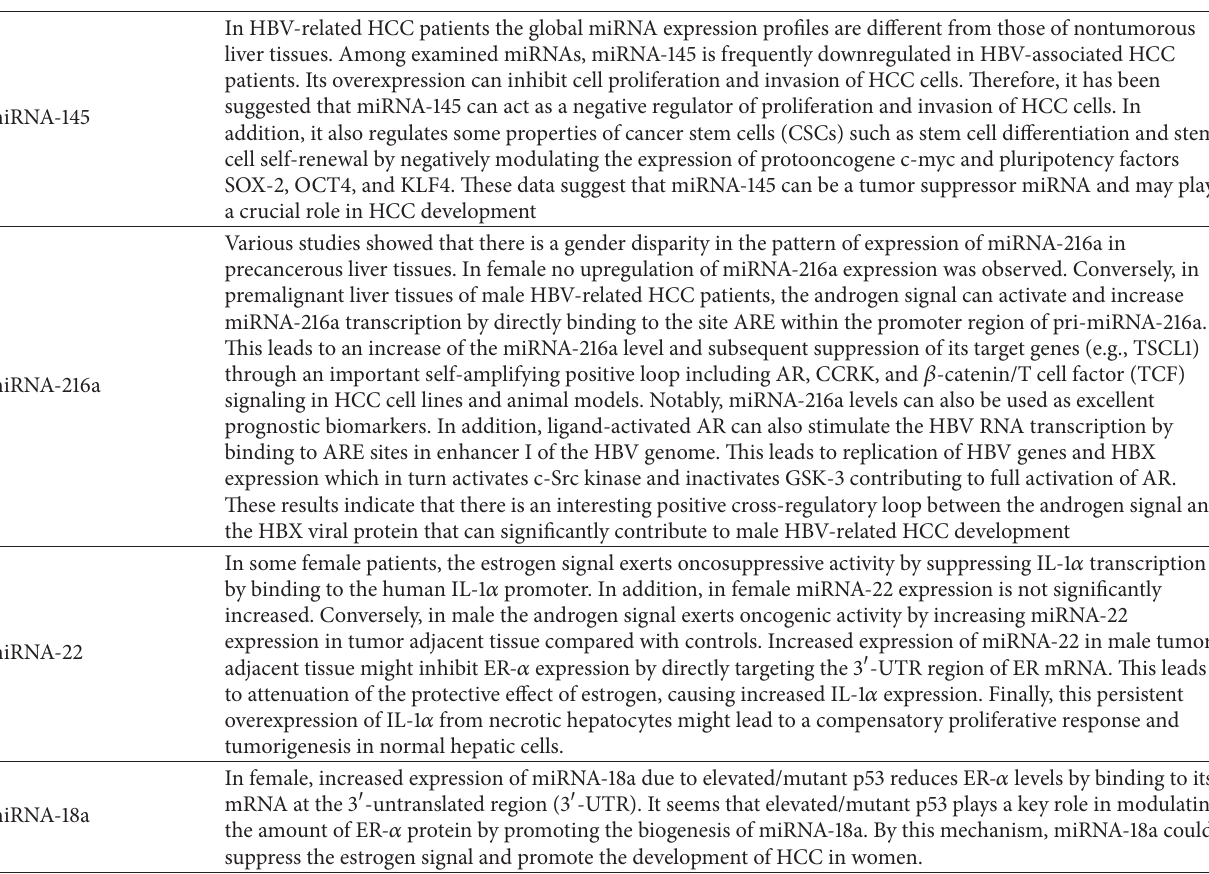
Table 1: Functional activities of specific miRNAs in HBV-associated hepatocarcinogenesis process between female and male.